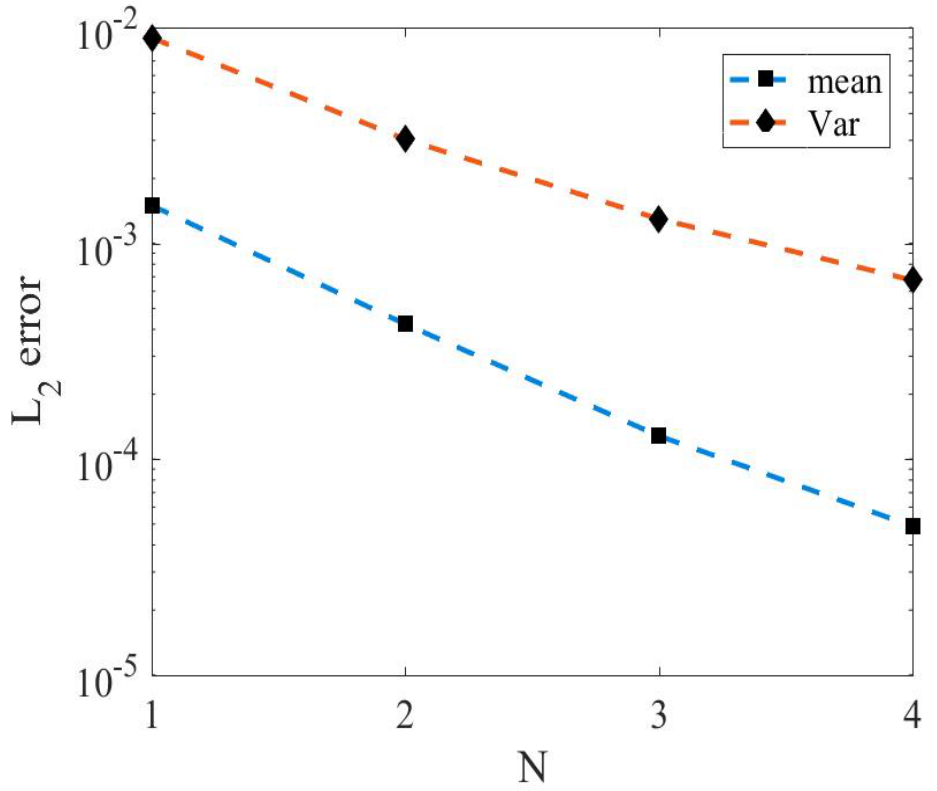
Figure 10. Mean L 2 error ( left ) and variance error ( right ) for the inviscid Burgers’ equation at t f =3 , switching at t s =1 with different modes: N =2, N =3 and N =4 .